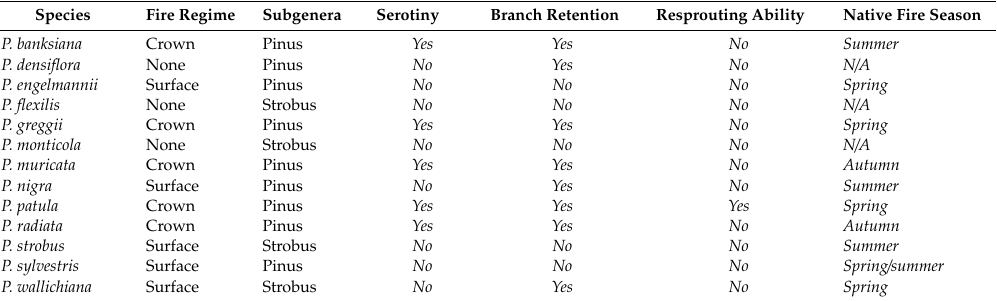
Table 1. Pine species, traits and fire regimes. Information in this table is adapted from He et al.